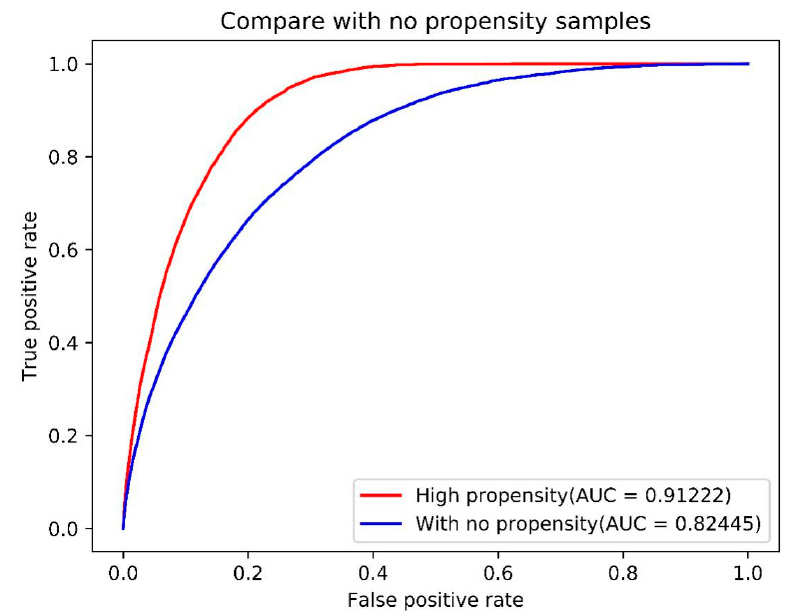
Figure 1. Receiver operating characteristic (ROC) curve and area under the curve (AUC) score of samples with high binding propensity and samples with no binding propensity.